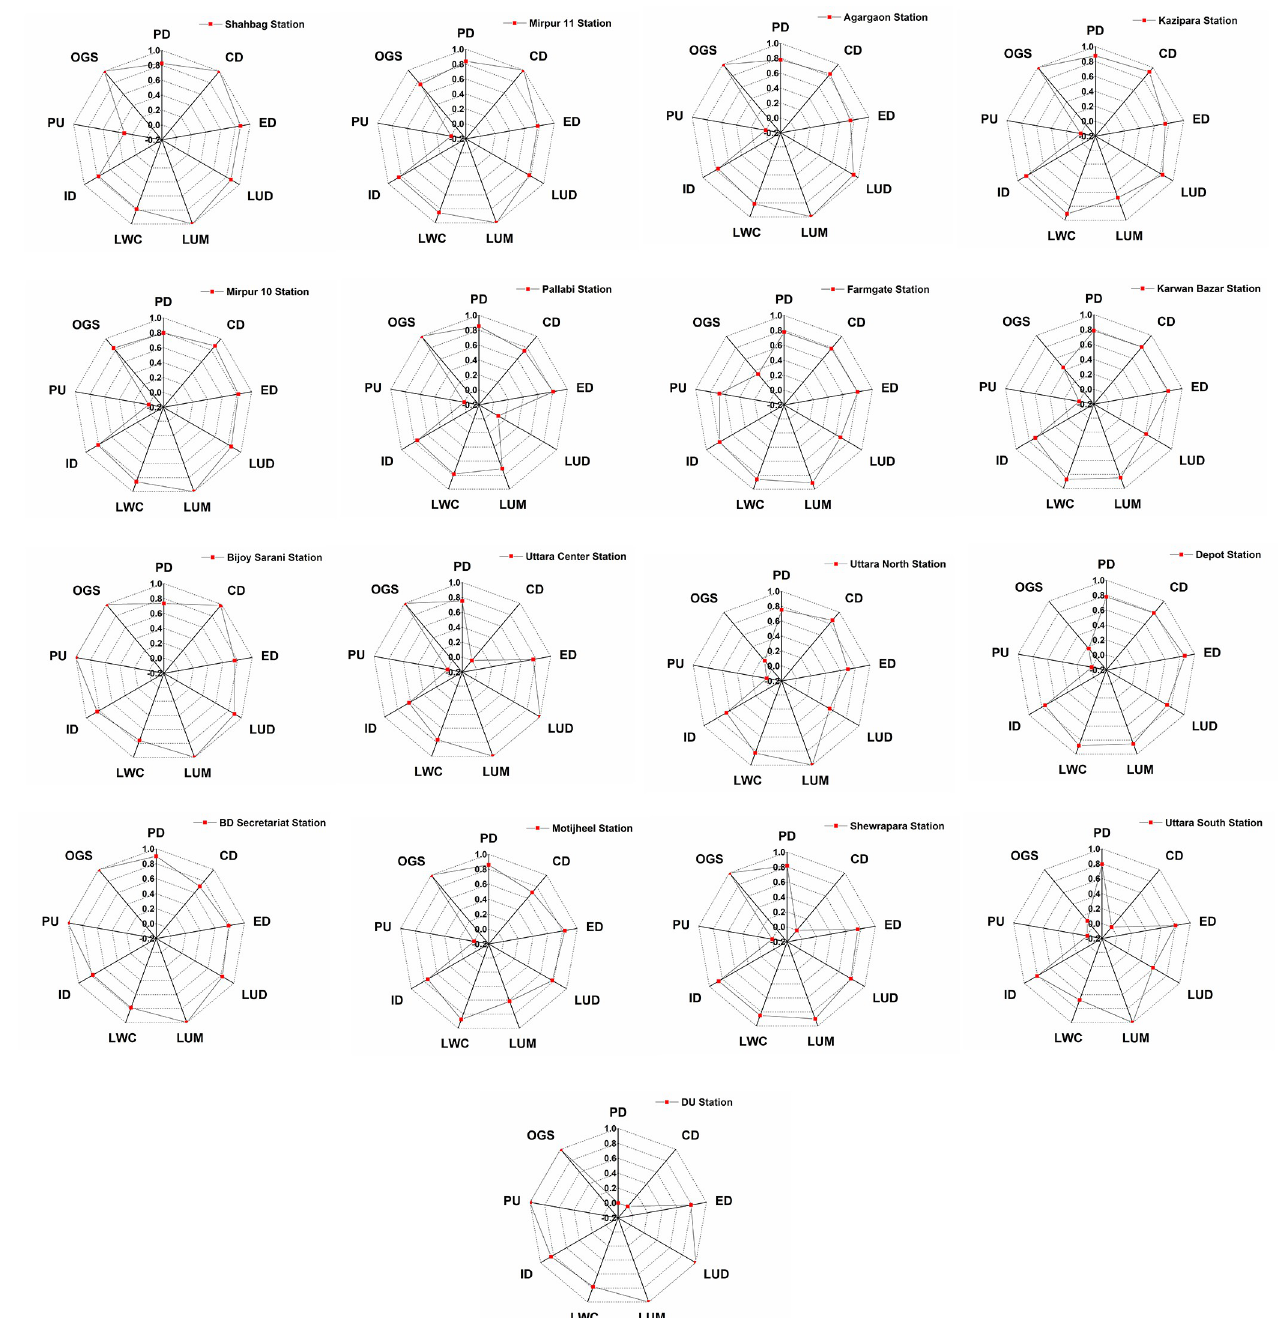
Fig 12. Web diagrams of TOD indicators of 17 stations–(a) Shahbag, (b) Mirpur 11, (c) Agargaon, (d) Kazipara, (e) Mirpur 10, (f) Pallabi, (g) Farmgate, (h) Karwan Bazar, (i) Bijoy Sarani, (j) Uttara Center, (k) Uttara North, (l) Depot, (m) BD Secretariat, (n) Motijheel, (o) Shewrapara, (p) Uttara South and (q) DU station (Arranged in order based on TOD